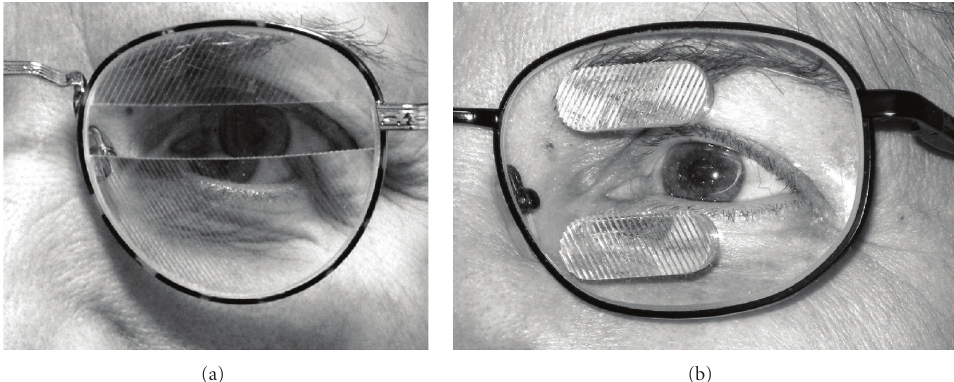
Figure 1: (a) Press-on 40 Δ Fresnel peripheral prism segments in the oblique configuration on the left spectacle lens as fitted for the study to a patient with left HH. The upper prism is base out and base down, and the lower prism is base out and base up, shown with 9mm interprism separation, providing expansion in the central area of the visual field used when driving (Figure 2(b)). The e ff ect of the lower prism is notable by the apparent shift of the centrally located lower lid margin, iris, and sclera (imaged by the prism segment). The wearer has an uninterrupted binocular view through the central prism-free area of the lens. (b) Higher-power, 57 Δ permanent prism glasses in the oblique configuration with 12mm interprism separation (not used in this study, but now available from Chadwick Optical Inc., White River Junction, VT,